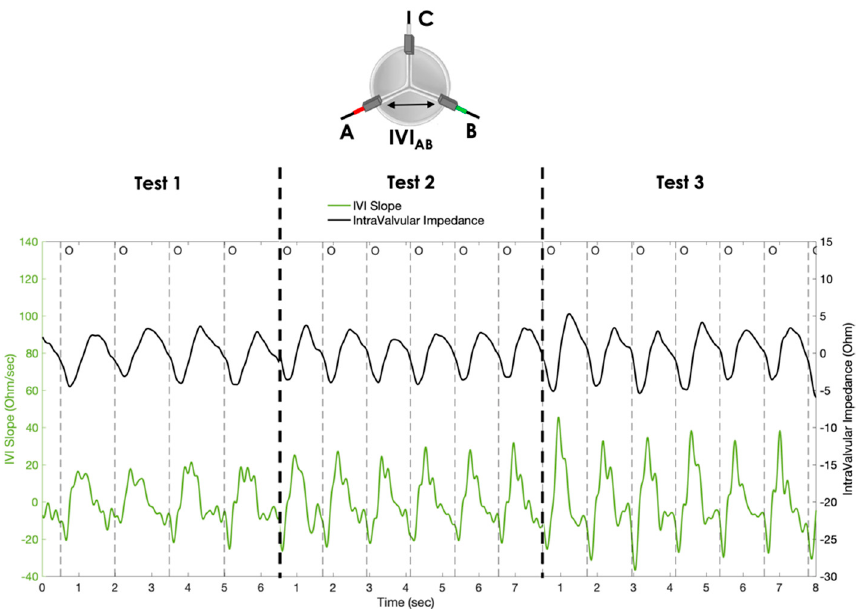
Figure 12. IVI signal (black line) and the corresponding dIVI/dt (green line) obtained with the AB